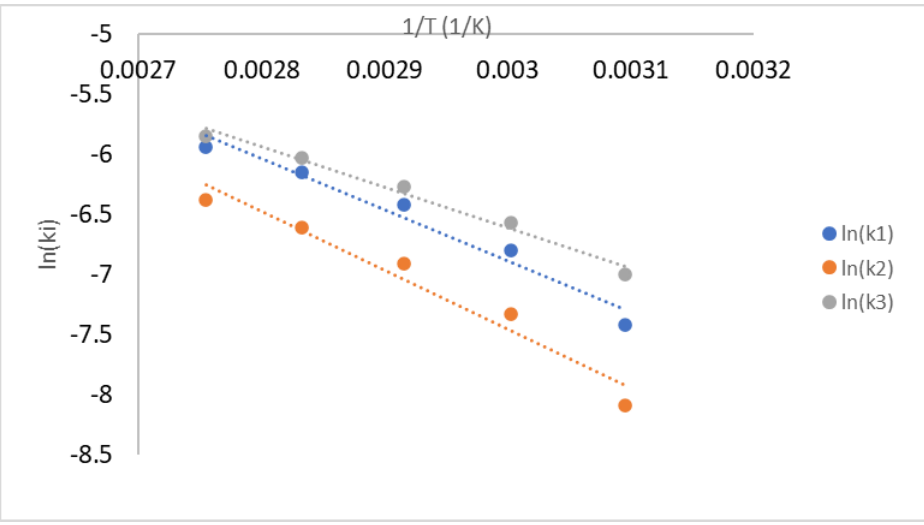
Figure 8. The plot of ln (k i ) vs. 1/T for hexogen coating with polyurethane.